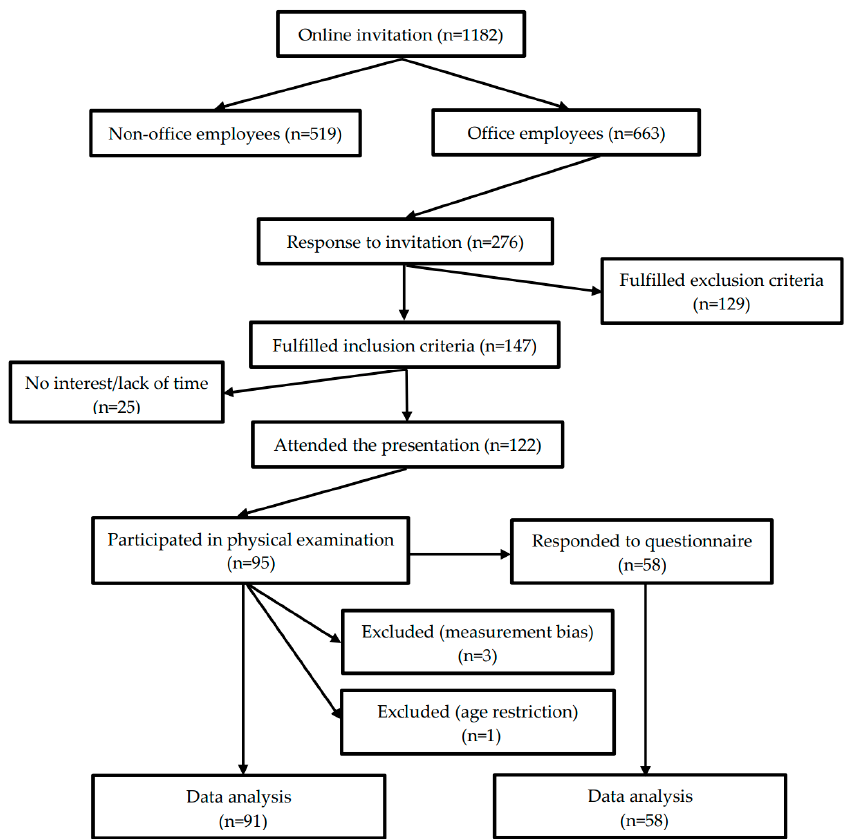
Figure 1. Flow diagram of selecting subjects for the study.